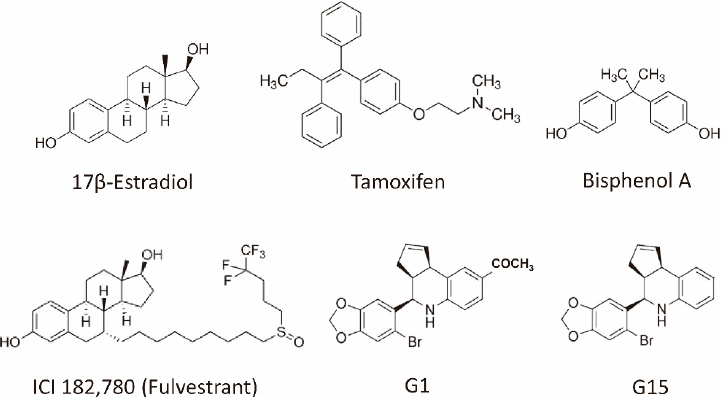
Figure 1. Structures of the representative GPER agonists and antagonists. 17 β -estradiol is one of the major physiological forms of estrogen. Tamoxifen is both a selective estrogen receptor modulator and an agonist for the GPER. Bisphenol A is a xenoestrogen. Fulvestrant is a selective estrogen receptor downregulator (ER antagonist) and an agonist for the GPER. G-1 is a selective GPER agonist, whereas G15 is a selective GPER antagonist. Abbreviation: ER, estrogen receptor; GPER, G-protein coupled estrogen receptor.